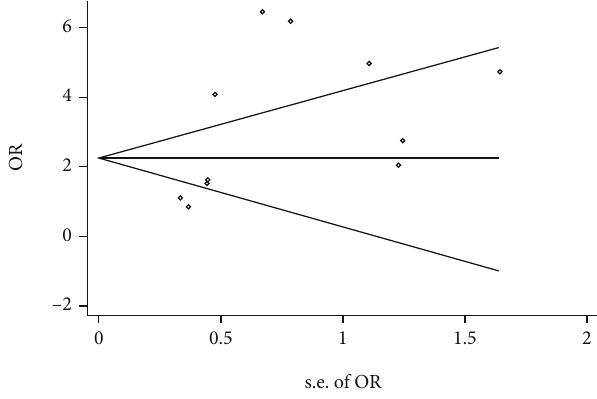
Figure 7: Begg ’ s funnel plot for studies of AGT p.Thr174Met polymorphism associated with myocardial infarction using a recessive genetic model (MM vs. TM+TT). OR: odds ratio; SE: standard